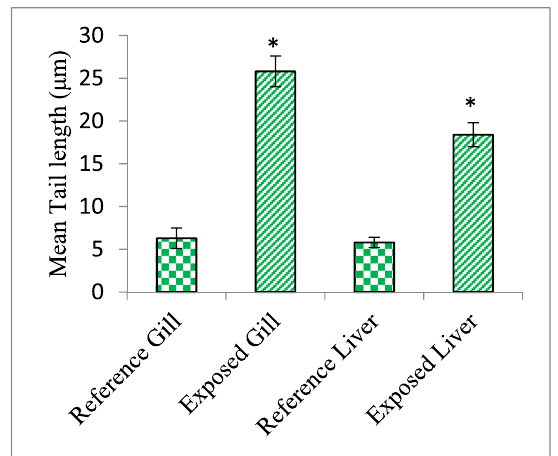
Fig. 2 Mean tail length (µm) of DNA comets in Labeo rohita in gill and liver tissues collected from reference and exposed samples. Signi fi cance was established at p < 0.05; symbol (*) indicates signi fi cant